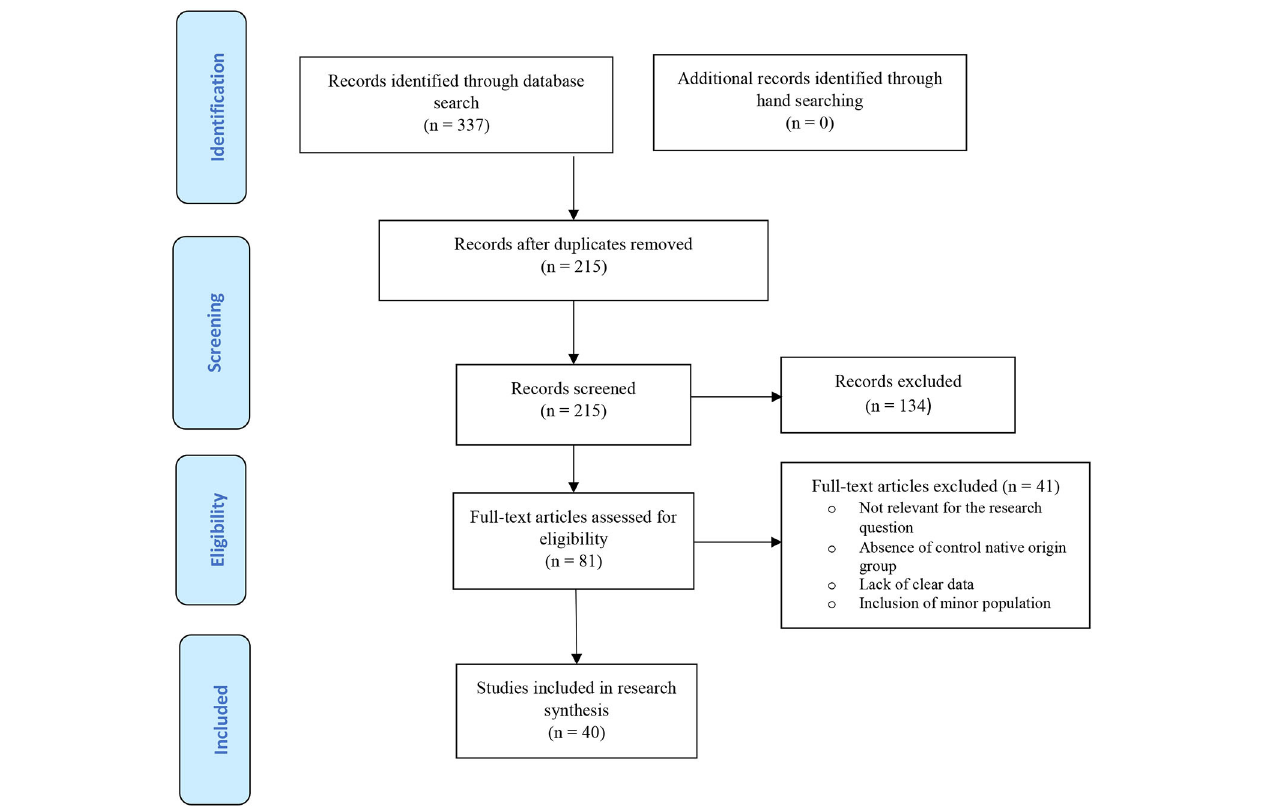
FIGURE 1 | The PRISMA flowchart of the search